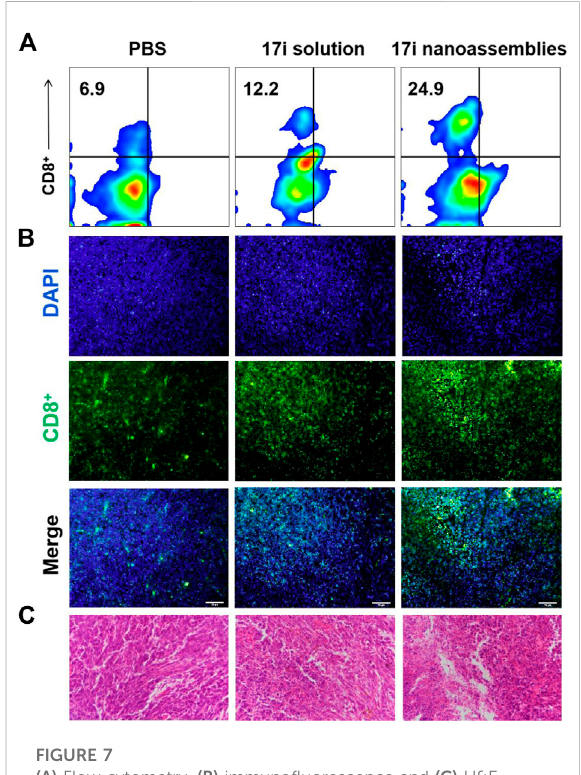
FIGURE 7 (A) Flow cytometry, (B) immuno fl uorescence and (C) H&E stained images of tumor slices. The nuclei were stained with DAPI (blue) and CD8 antibody (green). Scale bar = 50 μ